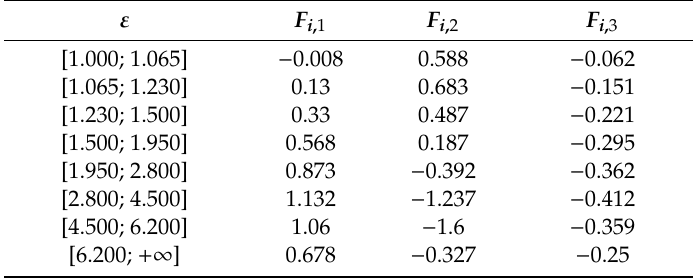
Table 1. Sub-coe ffi cients of irradiance for di ff erent classes of sky clearness. ε F i ,